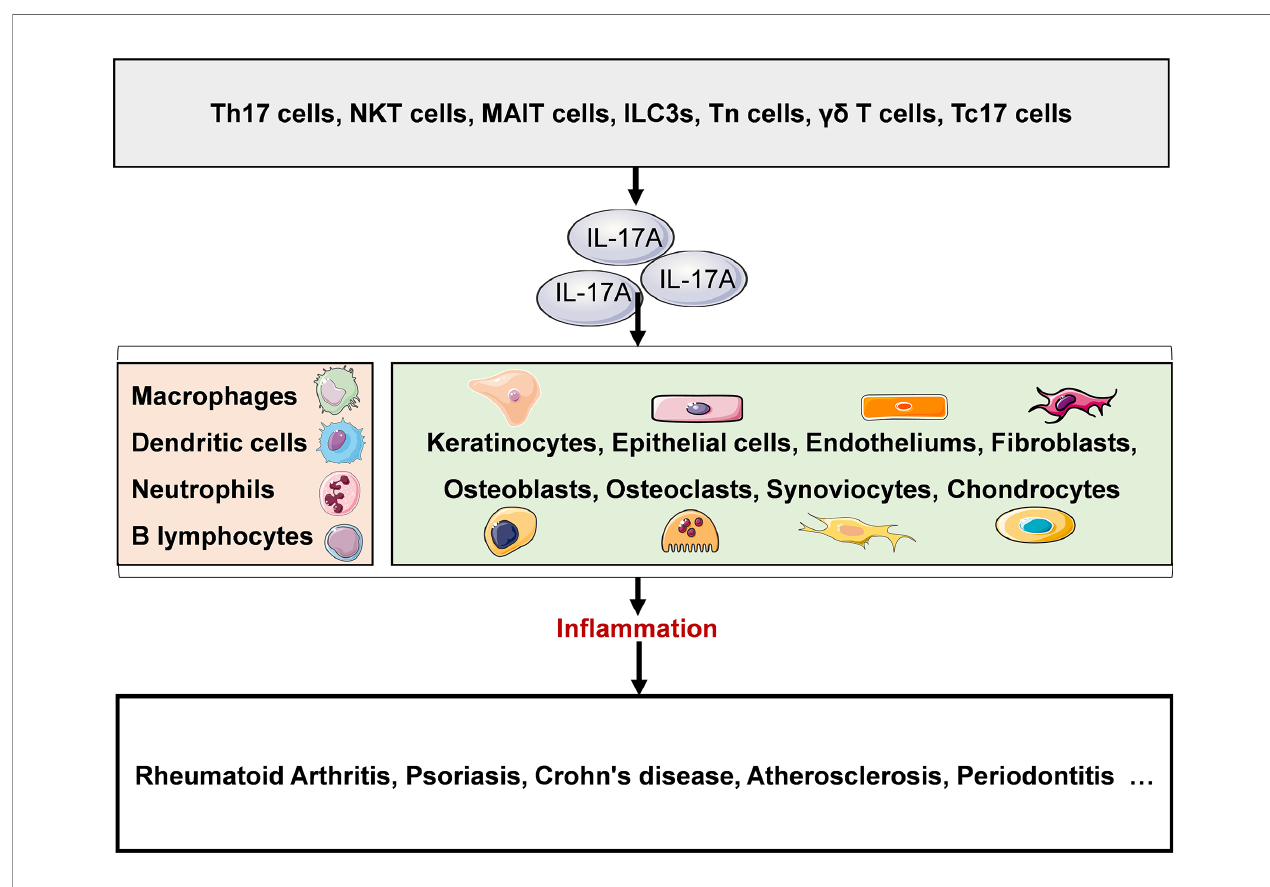
FIGURE 2 | IL-17A in disease. A variety of innate and adaptive immune cells include (NKT cells, MAIT cells, ILC3s, Tn cells, gd T cells, Tc17 cells and Th17 cells can secrete IL-17A. IL-17A plays a proin fl ammatory role and is closely associated with several chronic in fl ammatory diseases, such as rheumatoid arthritis, psoriasis, Crohn ’ s disease, atherosclerosis, and periodontitis. NKT, natural killer T; MAIT, mucosal associated invariant T; ILC3s, group 3 innate lymphoid cells; Tn, naive T; gd T, gamma-delta T; Th, helper T. Original elements used in this diagram and Figures 3 – 5 are from Servier Medical Art (smart.servier.com/), and were modi fi ed